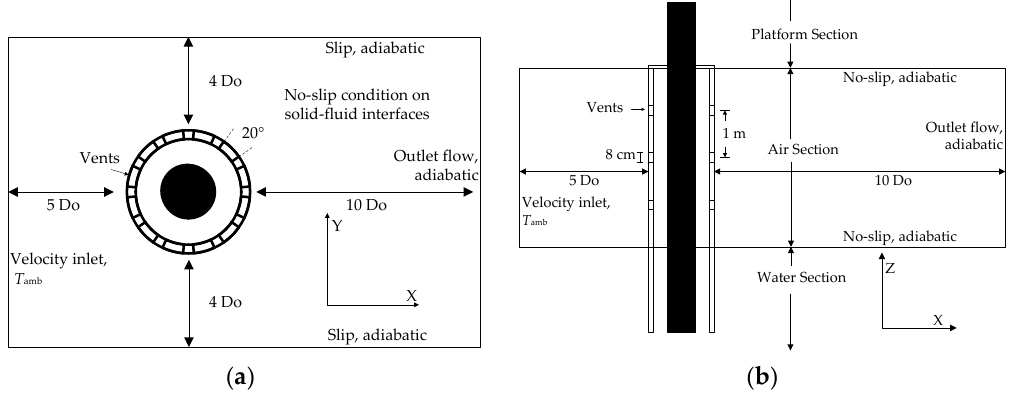
Figure 3. Computational domain and boundary conditions from different views for the ventilated J-tube system: ( a ) view along the negative Z coordinate; and, ( b ) view along the positive Y coordinate. The final step is defining the boundary conditions of the domain, as shown in Figure 3.